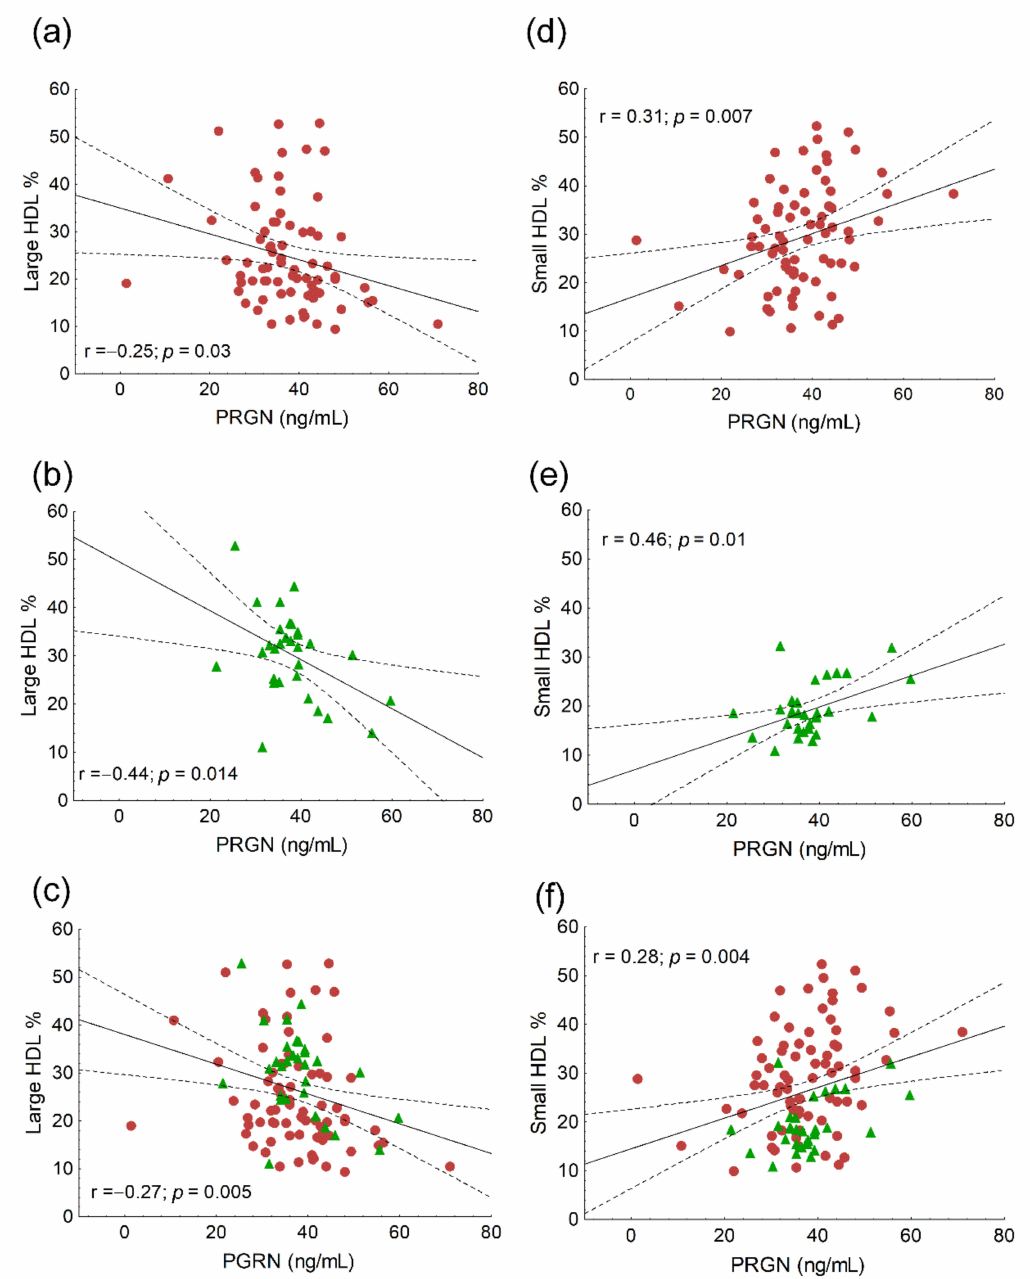
Figure 2. The correlations between the ratio of large HDL subfractions and serum progranulin (PGRN) in heterozygous familial hypercholesterolemic (HeFH) patients ( a ), healthy controls ( b ) and the whole study population ( c ). The correlations between the ratio of small HDL subfractions and serum progranulin (PGRN) in heterozygous familial hypercholesterolemic (HeFH) patients ( d ), healthy controls ( e ) and the whole study population ( f